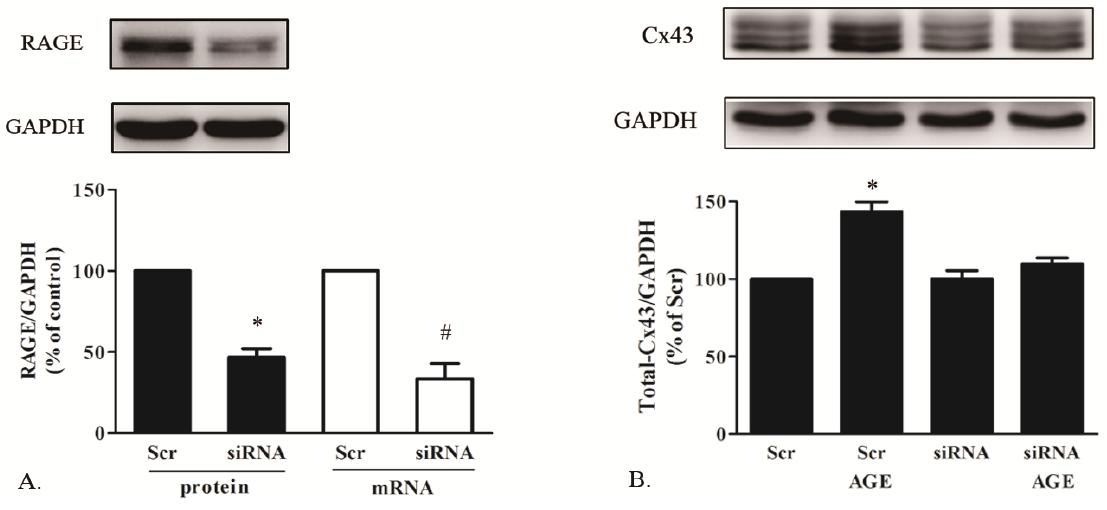
Figure 5. The effect of AGE on Cx43 expression in cardiomyocytes with RAGE knocked down. ( A ) The identification of RAGE expression knocked down with small interfering (siRNA) assessed by Western blot and real-time polymerase chain reaction (PCR); ( B ) The effect of AGE on Cx43 protein in cardiomyocytes with or without RAGE knocked